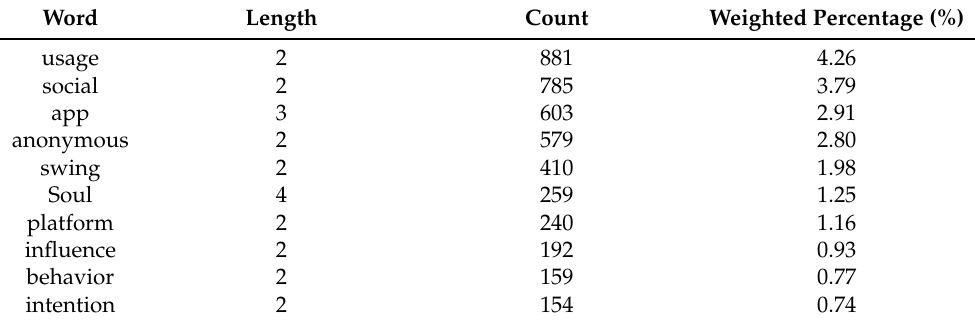
Table 2. Word Frequency Top 10 (in